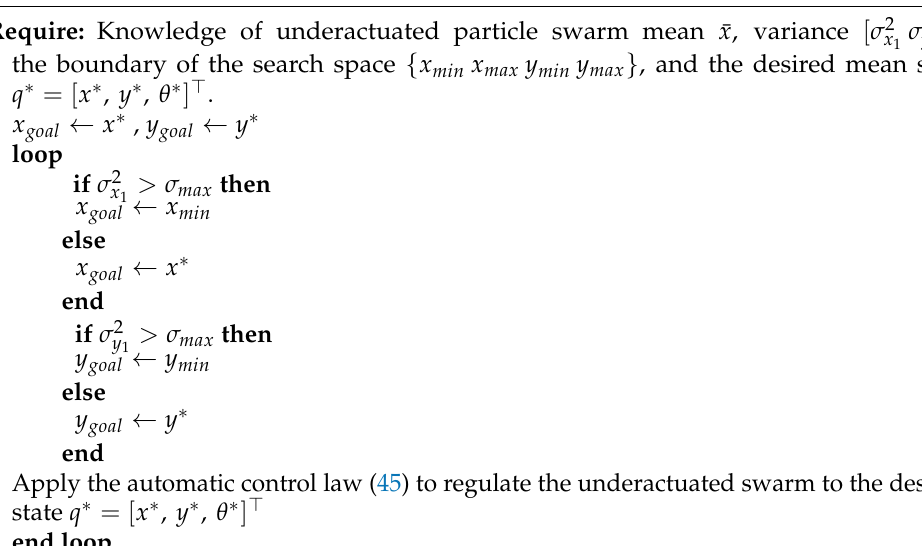
Algorithm 2 Hysteresis-based Mean and Variance Automatic Control